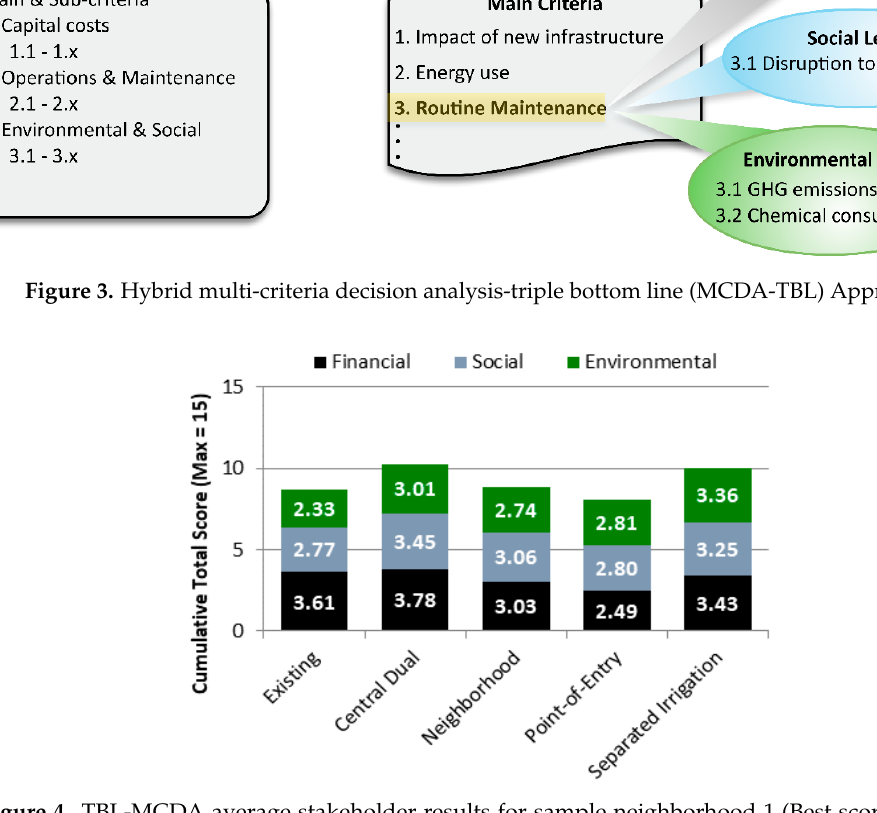
Figure 4. TBL-MCDA average stakeholder results for sample neighborhood 1 (Best score for each bottom line = 5 & Best cumulative score = 15) (Reproduced with permission from [42]).